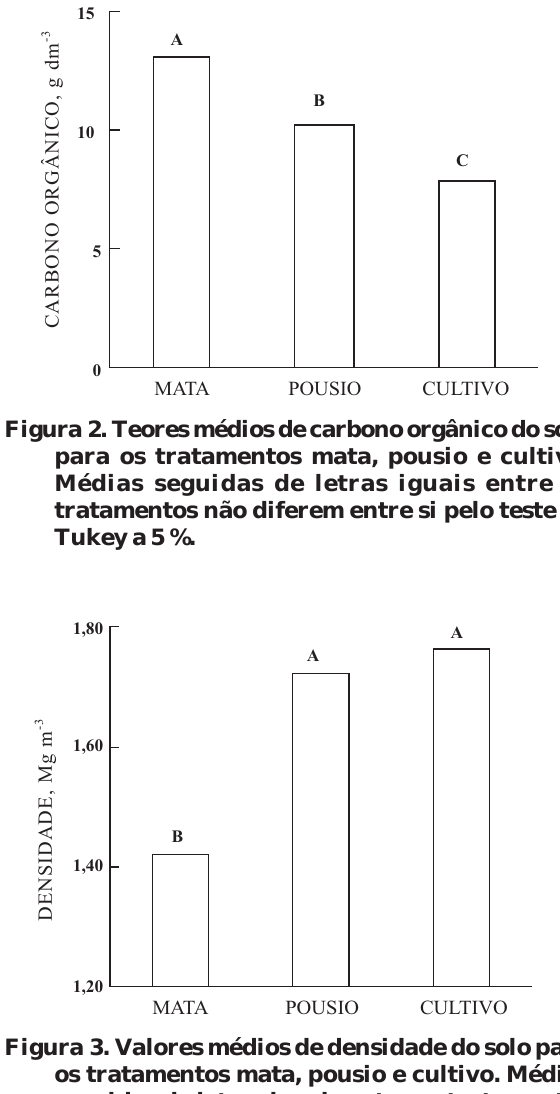
Figura 3. Valores médios de densidade do solo para os tratamentos mata, pousio e cultivo. Médias seguidas de letras iguais entre os tratamentos não diferem entre si pelo teste de Tukey a 5 %.